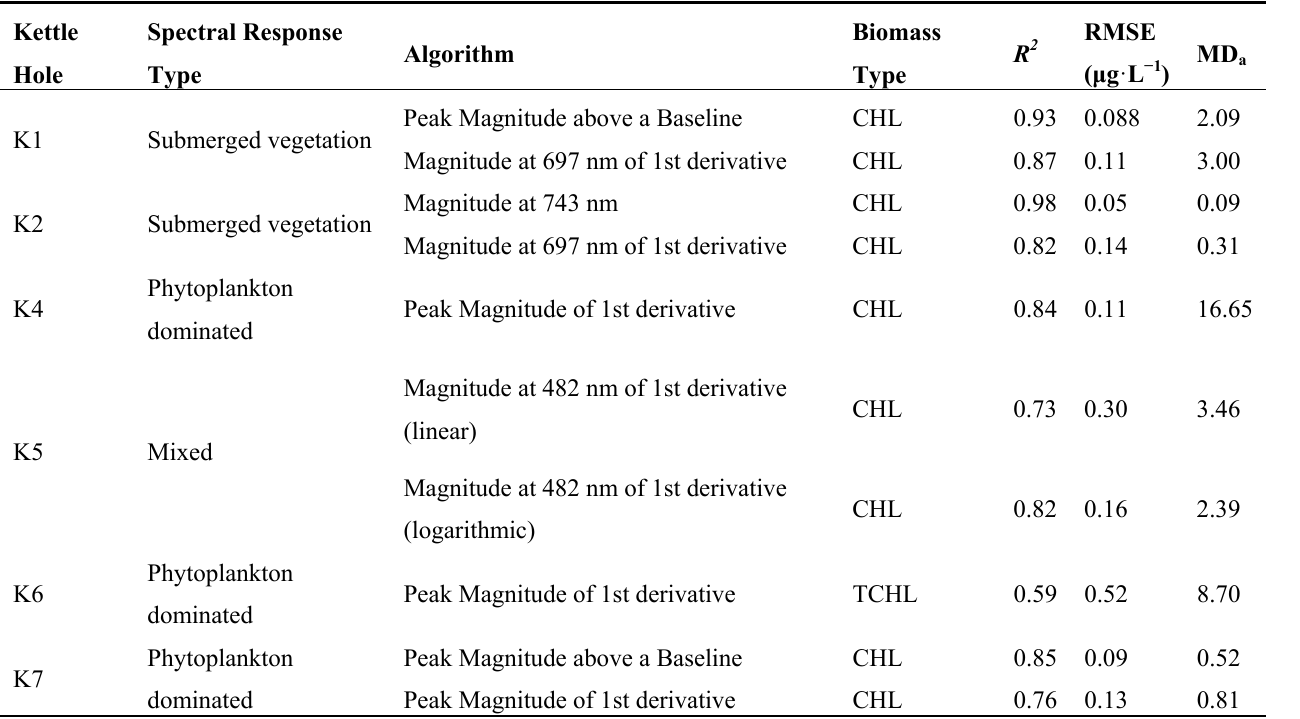
Table 3. Accuracy assessment of the best cross-seasonal algorithms for all studied kettle holes (n = 15 for 2007–08 season, only for K2 n = 5 in